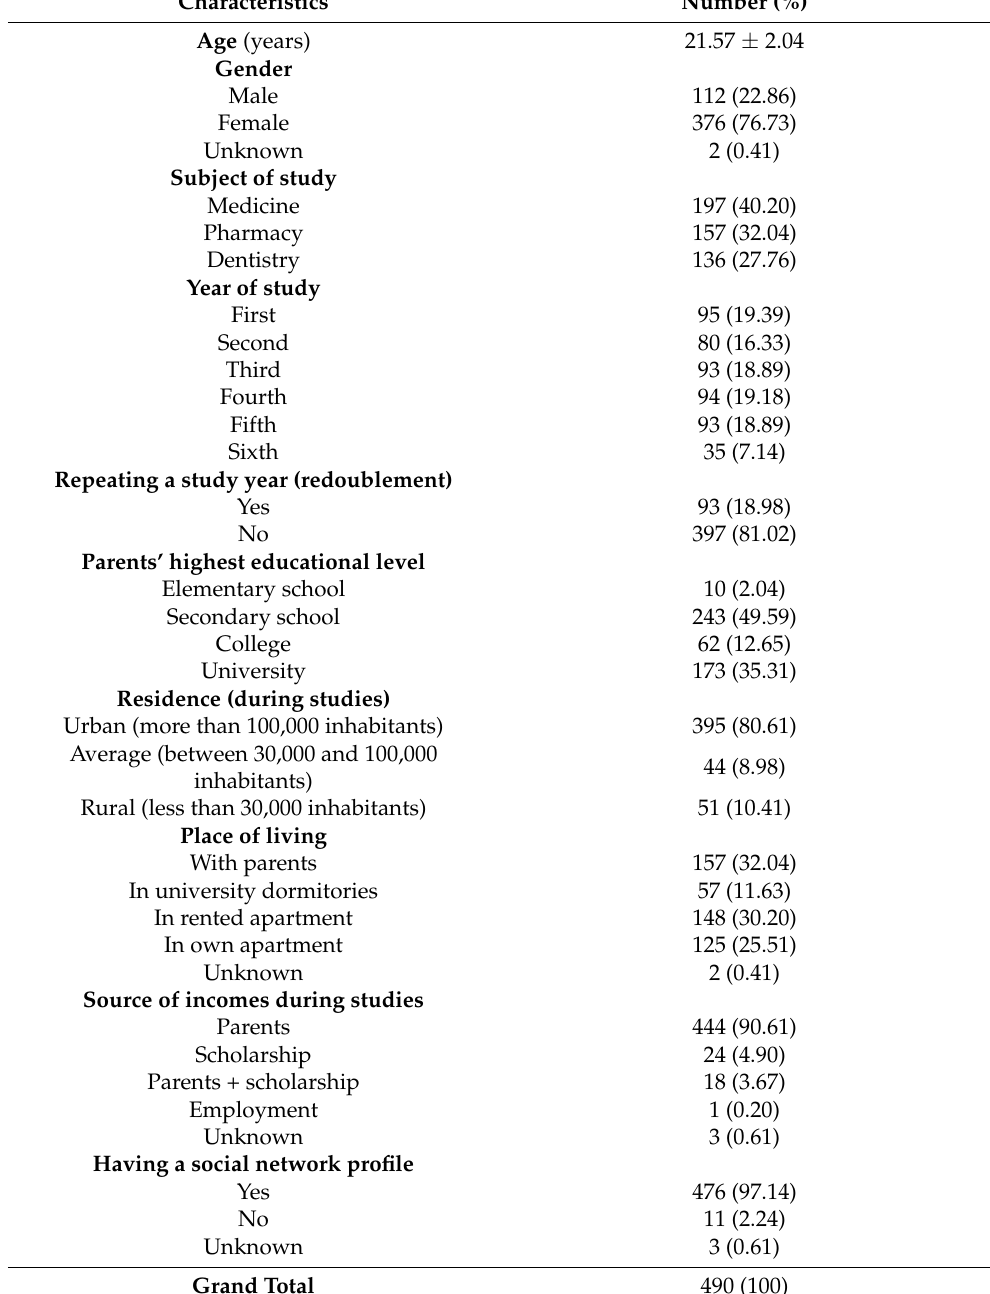
Table 1. Socio-demographic and academic characteristics of future HCPs in